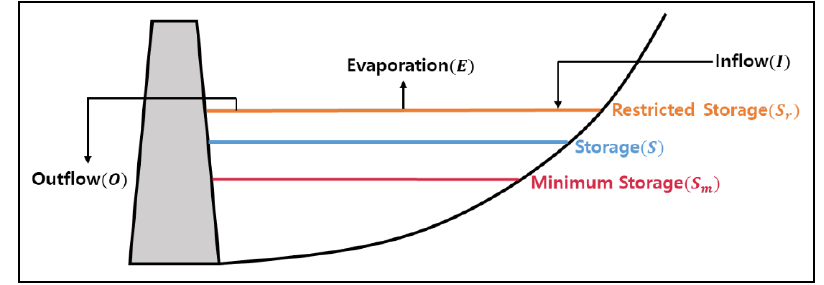
Figure 4. Dam water-budget analysis.